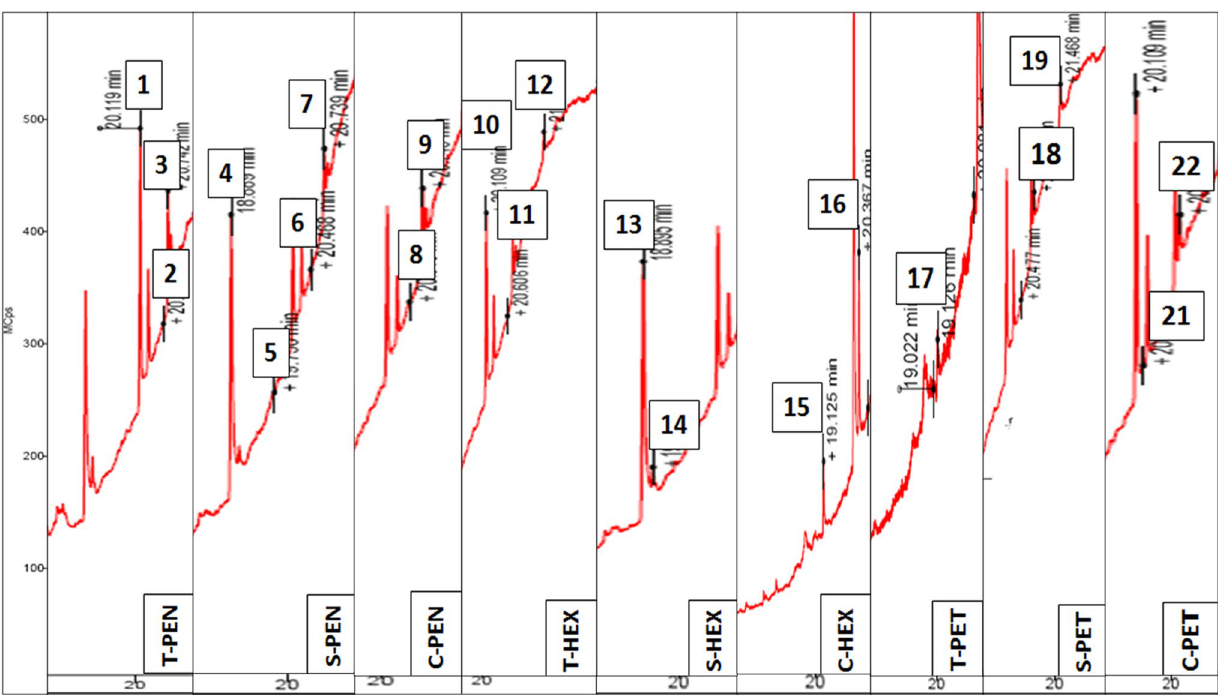
Fig. 3 Identification of halo phenols by gas chromatography and mass spectrophotometry. Note T Tiruchirappalli, S Srirangam, C control (before chlorinated water), PEN pentane (solvents), HEX hexane (solvents), PET petroleum ether